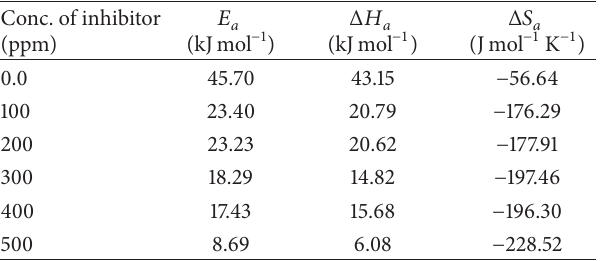
Table 3: Activation parameters for the corrosion of aluminum in 0.5 M phosphoric acid containing different concentrations of inhibitor CSE. Conc. of